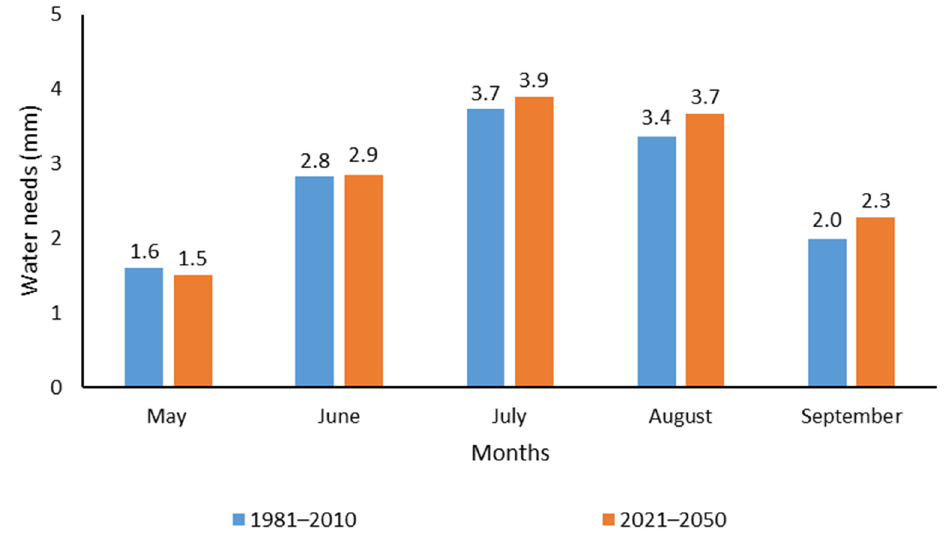
Figure 4. Daily water needs of grapevines during the growing season in the reference years (1981–2010) and in the forecast years (2021–2050).